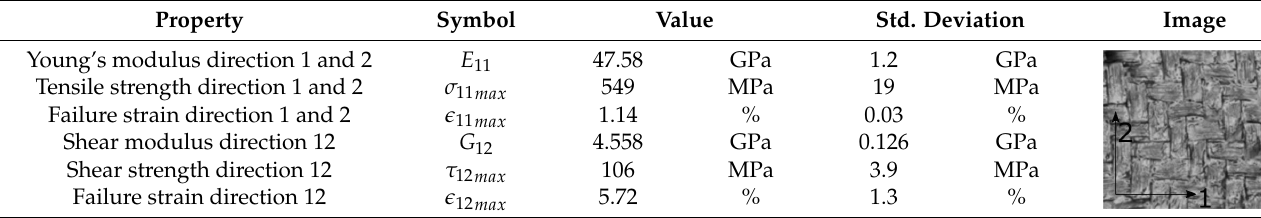
Table 1. Composite properties from the Krempel KGBX 2508 HT 3K prepreg.